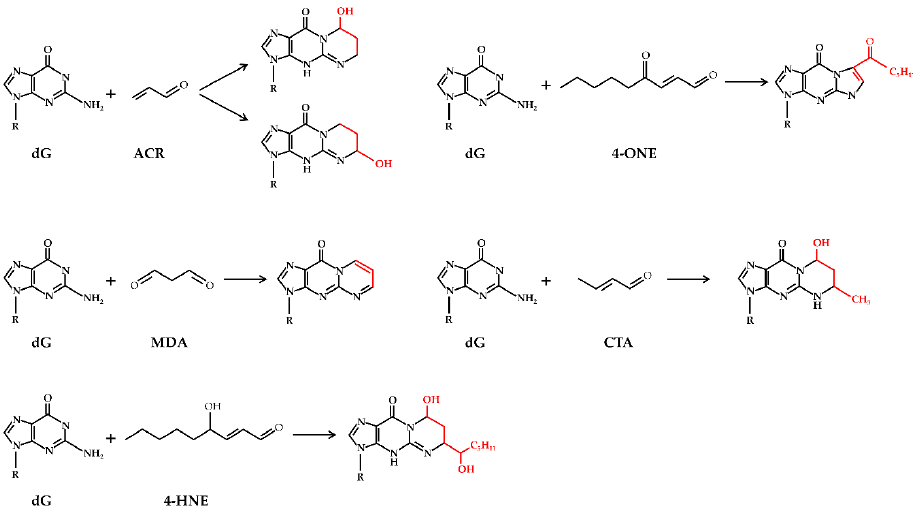
Figure 4. Hypothetical DNA adducts produced by reactive aldehydes.By reacting with DNA, in particular with the deoxyguanosine nucleobases, several reactive aldehydes such as ACR, MDA, 4-HNE, 4-ONE and CTA produce DNA modifications named exocyclic adducts that alter the DNA structure and, if not correctly repaired, may produce carcinogenic